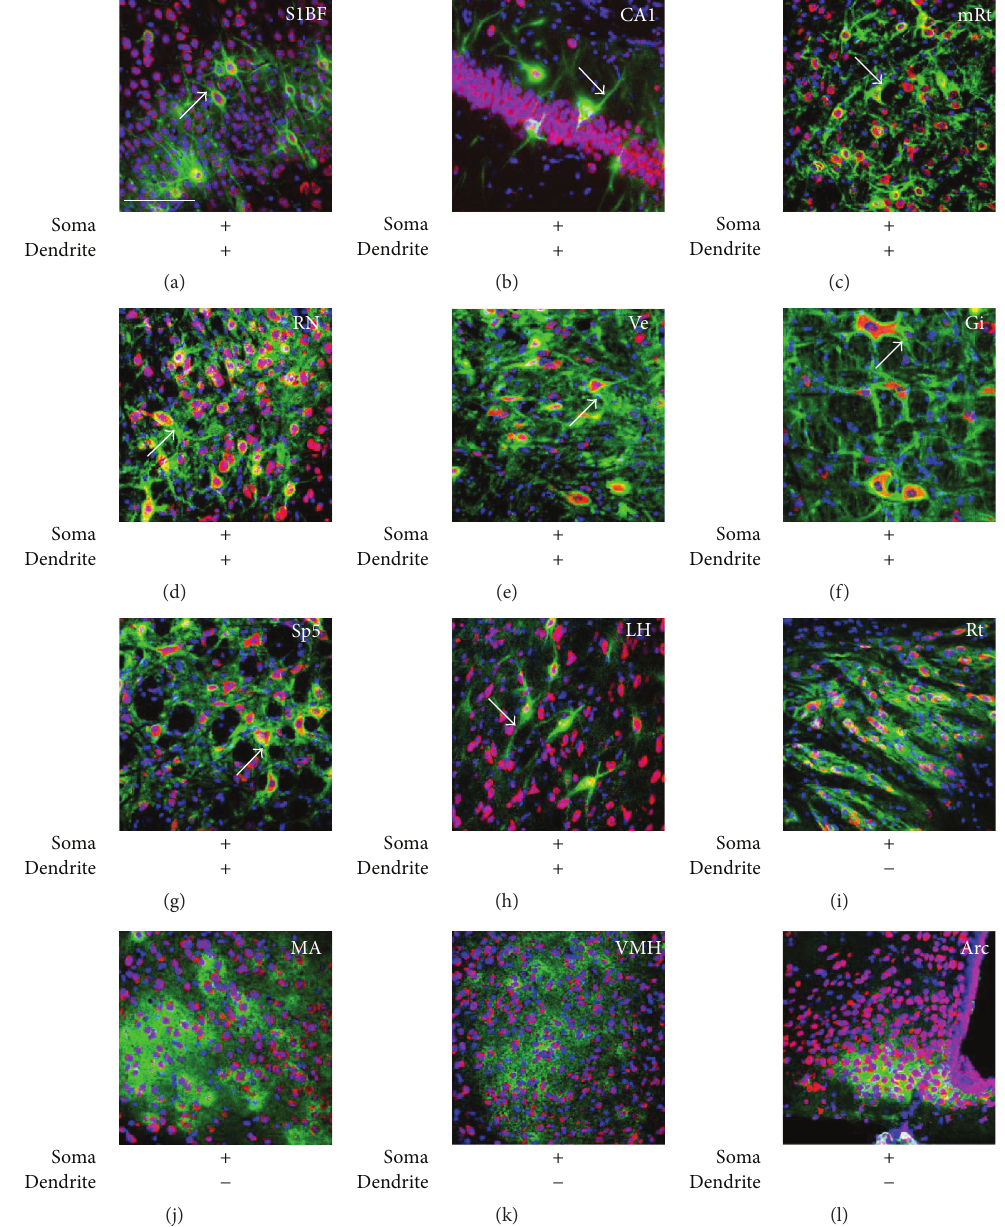
Figure 6: Structural variety of CSPG-contained ECM structures. (a–l) Fluorescent triple labeling of WFA (green), Nissl (red, neuron marker), and DAPI (blue, nucleus marker) at 11w. Arrows indicate WFA signals around dendrites. The sign of plus (+) or minus ( − ) below images indicates the presence or absence of WFA reactivity around somata and dendrites. WFA signals in the Cx (a), hippocampal CA1 (b), mRt (c), RN (d), Ve (e), Gi (f), Sp5 (g), and LH (h) were observed around both somata and dendrites, while those of the Rt (i), MA (j), VMH (k), and Arc (l) did not show clear reactivity surrounding dendrites. Arc: arcuate nucleus; Gi: gigantocellular nucleus; LH: lateral hypothalamus; MA: medial amygdaloid nucleus; mRt: mesencephalic reticular formation; RN: red nucleus; Rt: reticular thalamic nucleus; S1BF: barrel field of the primary somatosensory cortex; Sp5: spinal trigeminal nucleus; Ve: vestibular nucleus; VMH: ventromedial hypothalamic nucleus. Scale bar = 100 𝜇 m